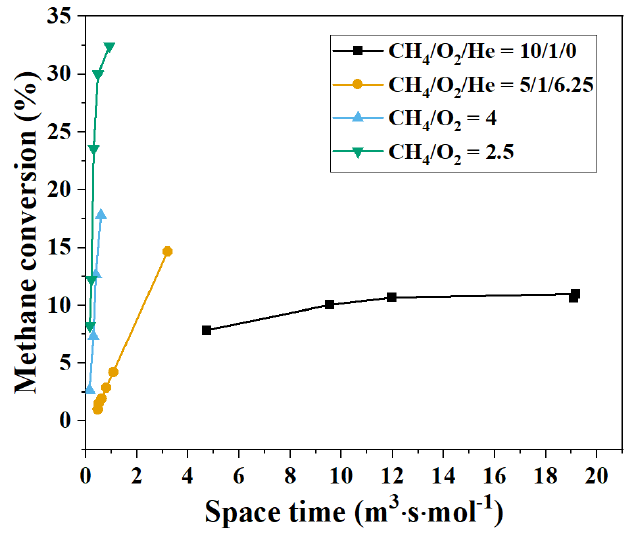
Figure 9. Effect of spatial time on experimental CH 4 conversion for different feed compositions at atmospheric pressure and in the absence of catalyst [96,97]. The maximum temperature across the reactor ranged between 790 and 826 °C at the analysed conditions. Spatial time is defined as the ratio between the reactor volume and the inlet molar flow rate of CH 4 .